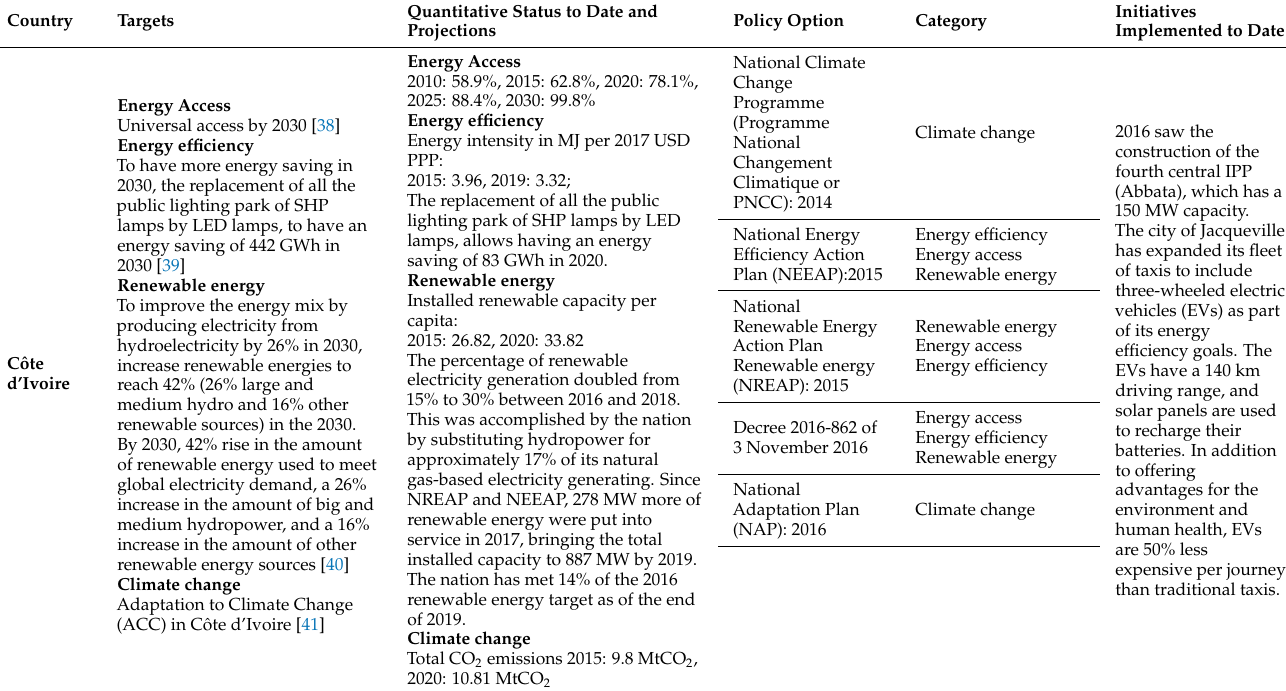
Table 4. C ô te d’Ivoire (data from [22–24]).